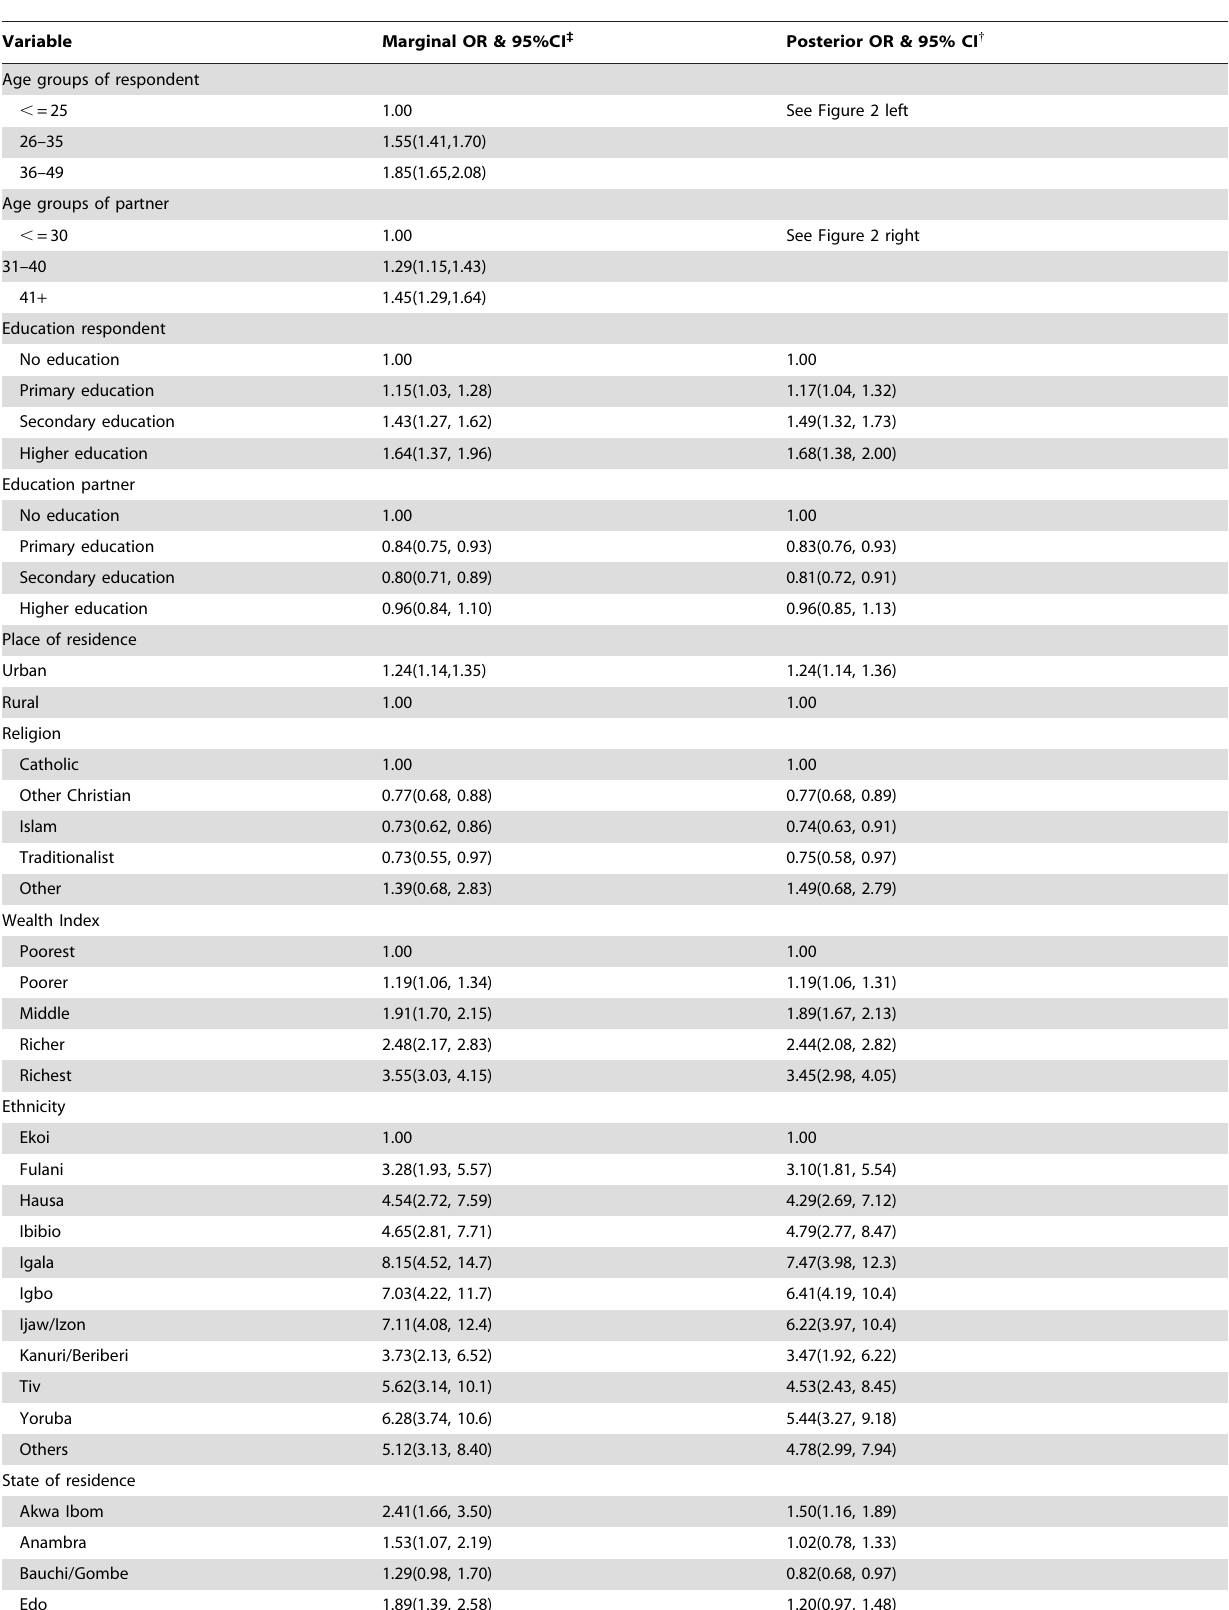
Table 3. Marginal and posterior odds ratios of overweight/obesity across selected covariates (NDHS,